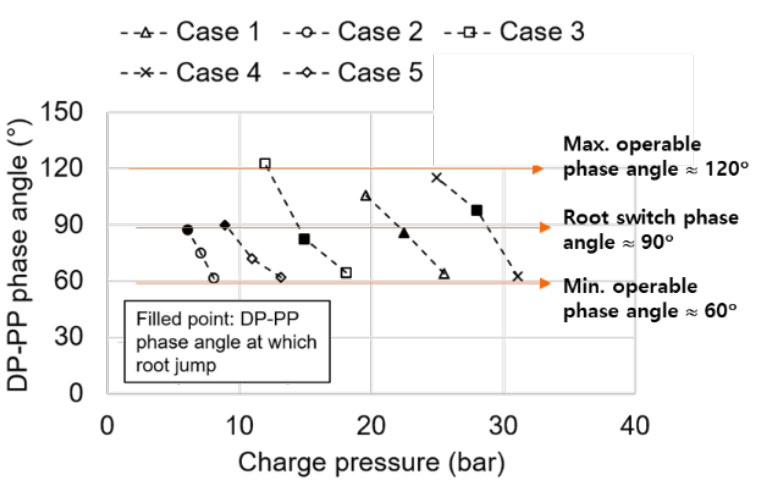
Figure 14. Measured DP–PP phase angle of test FPSE with increasing charge pressures for experi- cases